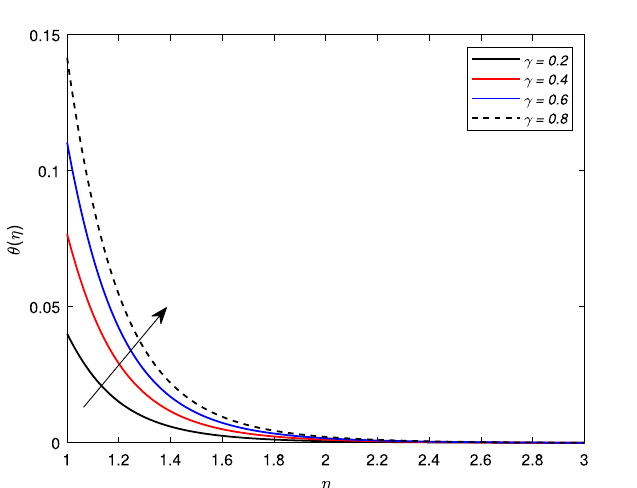
Figure 7. Impact of Biot number γ on temperature profile θ(η)